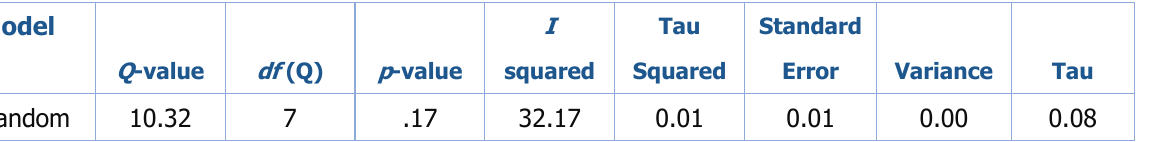
Table 4. Heterogeneity